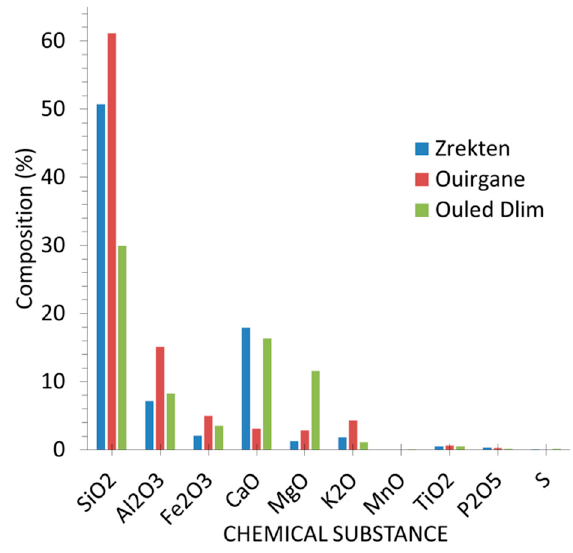
Figure 5. Chemical analysis of the soils.